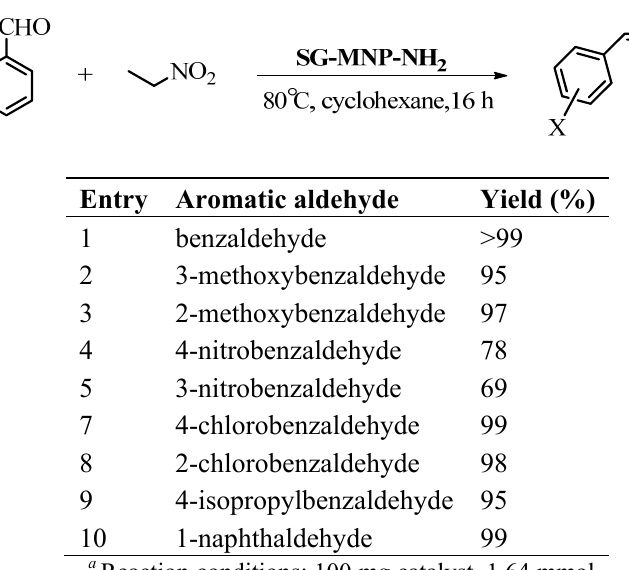
Table 2. Nitroaldol condensation of nitroethane with different aromatic aldehydes catalyzed by the catalyst SG-MNP-NH